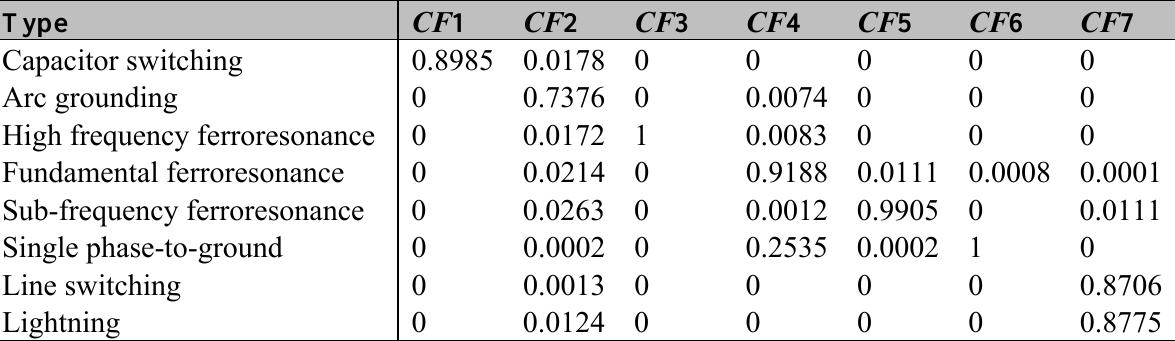
Table 4. Confidence factor of eight kinds of over-voltages.